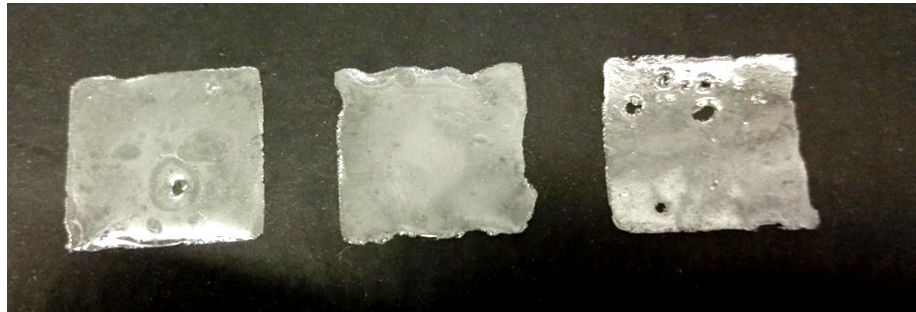
Figure 7. Three epoxy resin samples with different thicknesses after 31 days in sulfuric acid .